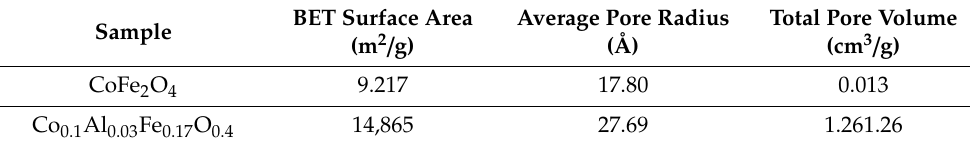
Table 2. Nitrogen adsorption / desorption results of undoped and doped ferrites.